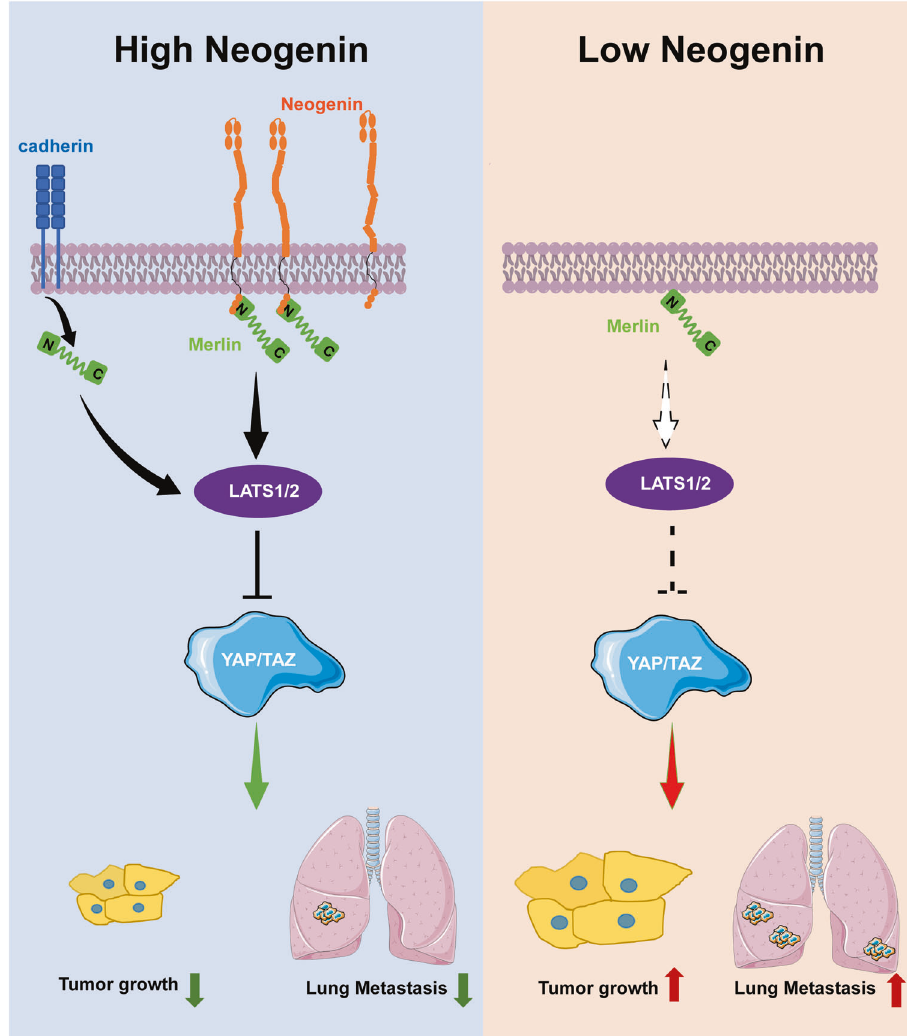
Fig. 7 Model of Neogenin regulation of tumorigenesis and metastasis. Schematic illustration depicting the roles of Neogenin in suppressing tumor growth and metastasis. Note that the anti-oncogenic potential of Neogenin is likely attributed to Merlin/YAP